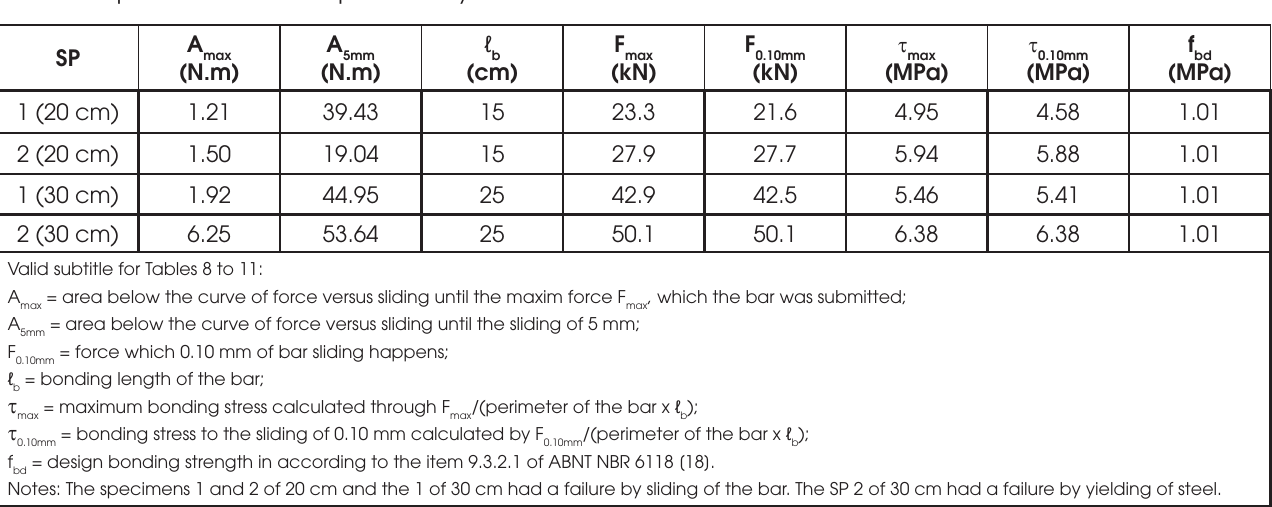
Adherence between steel bars and lightweight concrete with EPS